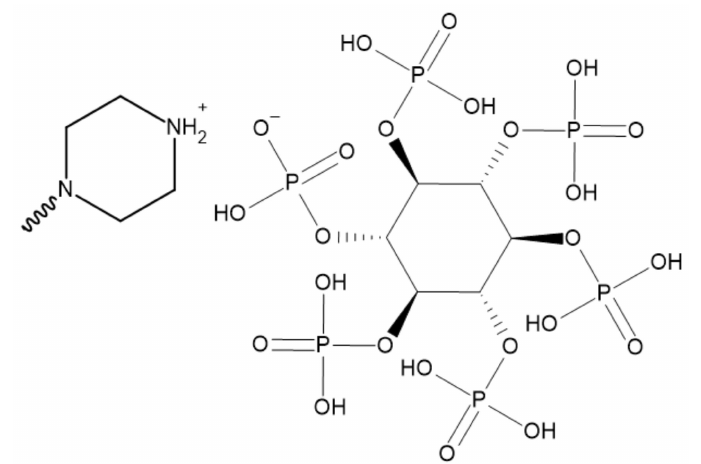
Figure 16. The structure of the piperazine phytate